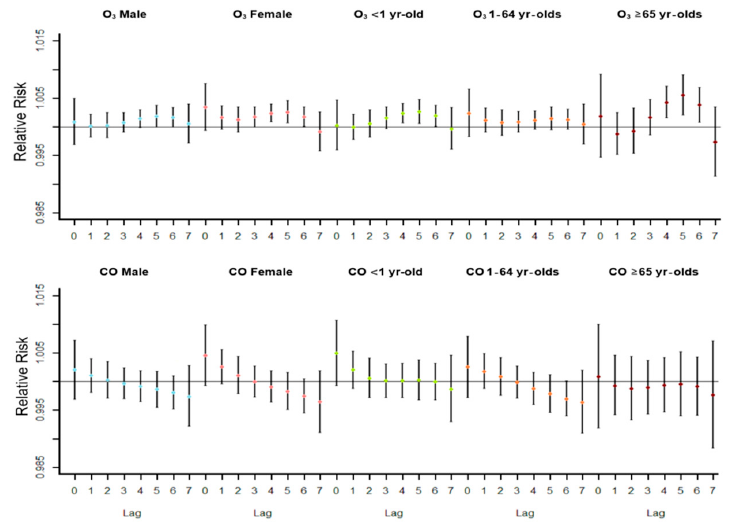
Figure 4. The relative risk of hospitalization for respiratory diseases in different populations was caused by an annual average of air pollutant concentration increased by 10%.